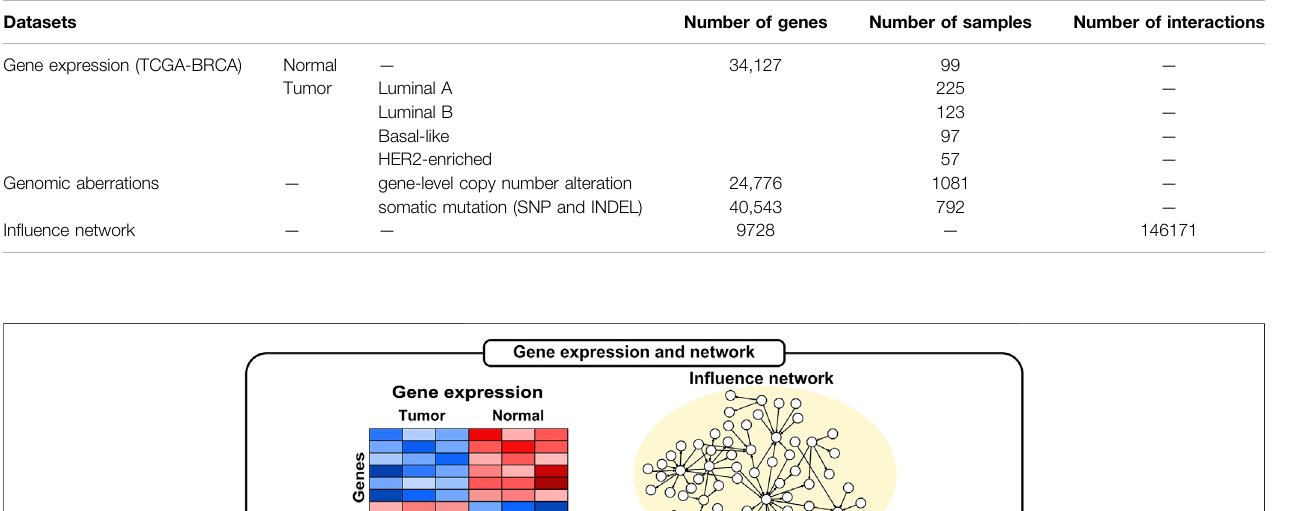
TABLE 1 | The details of datasets and network.